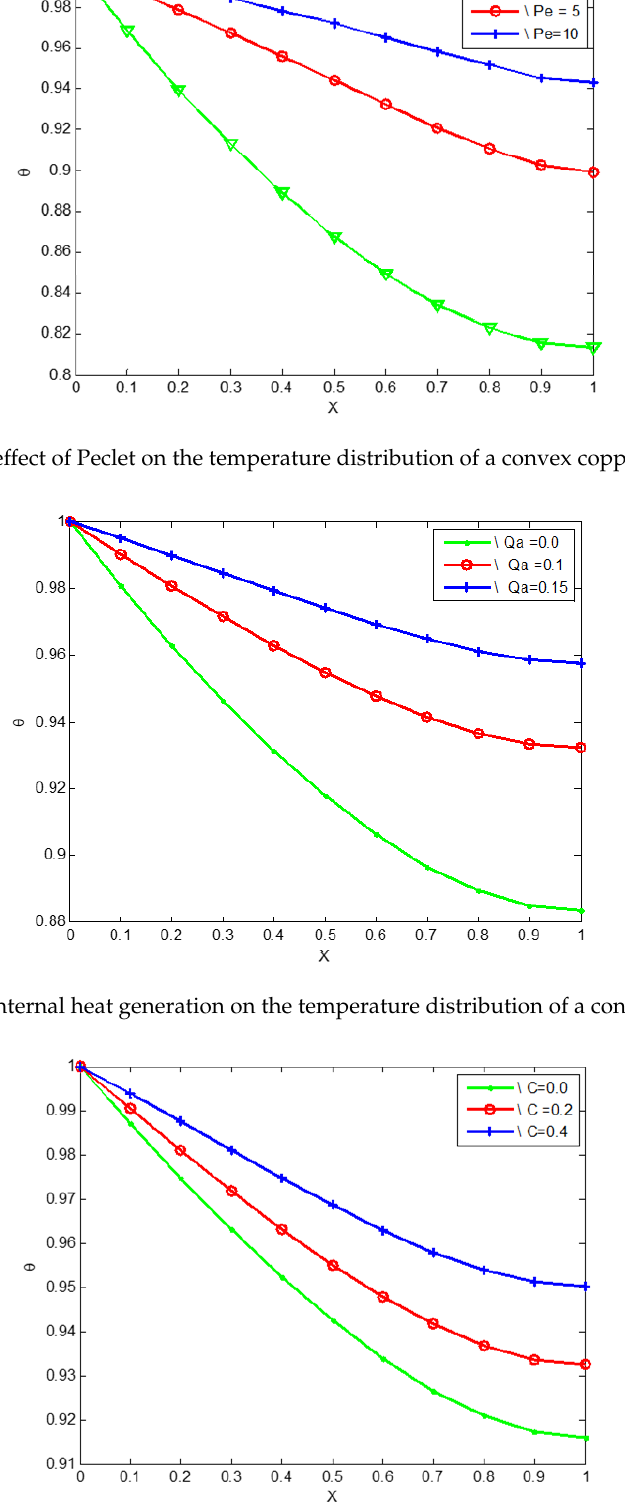
to void increment. However, the more the porosity the more the convective and radiative heat enhancement capacity of the fin due to large surface area. In Figure 14, the effect of convective conductive parameter